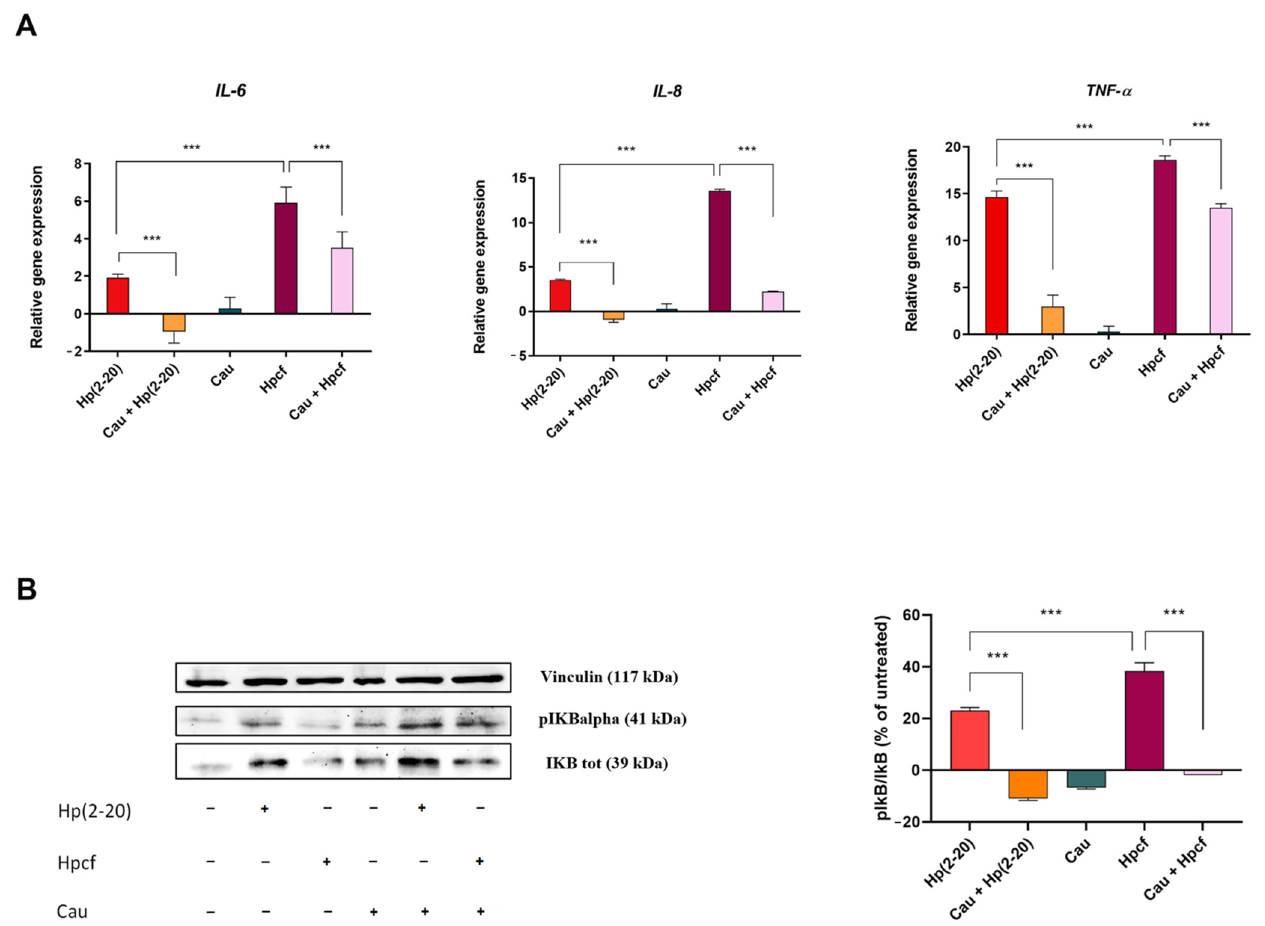
Figure 2. Cau significantly decreases the in vitro H. pylori -induced inflammatory response. ( A ) Relative gene expression of IL-6 , IL-8 and TNF - α was determined by quantitative real time PCR (qPCR), performed on RNA isolated from AGS cells cultured with Hp(2–20) 25 µ M or Hpcf for 2 h and cells pretreated with Cau 15 µ M and then cultured with Hp(2–20) 25 µ M or Hpcf for 2 h. All samples were normalized to GAPDH as the reference housekeeping gene. Furthermore, relative gene expression was normalized to basal activity (untreated control), in order to obtain relative fold expression. ( B ) Western Blot and densitometric analysis of the ratio pIkB- α /IkB- α , compared to control group. The analysis was performed on cell lysate prepared after stimulation with Hp(2–20) or Hpcf for 1 h with or without Cau pretreatment (30 min). Vinculin was used for normalization. Graphs report the results of at least three independent experiments, represented as means ± SD. Statistical analysis was performed by GraphPad Prisma software, using one-way ANOVA followed by Bonferroni post hoc correction. *** p < 0.0001.